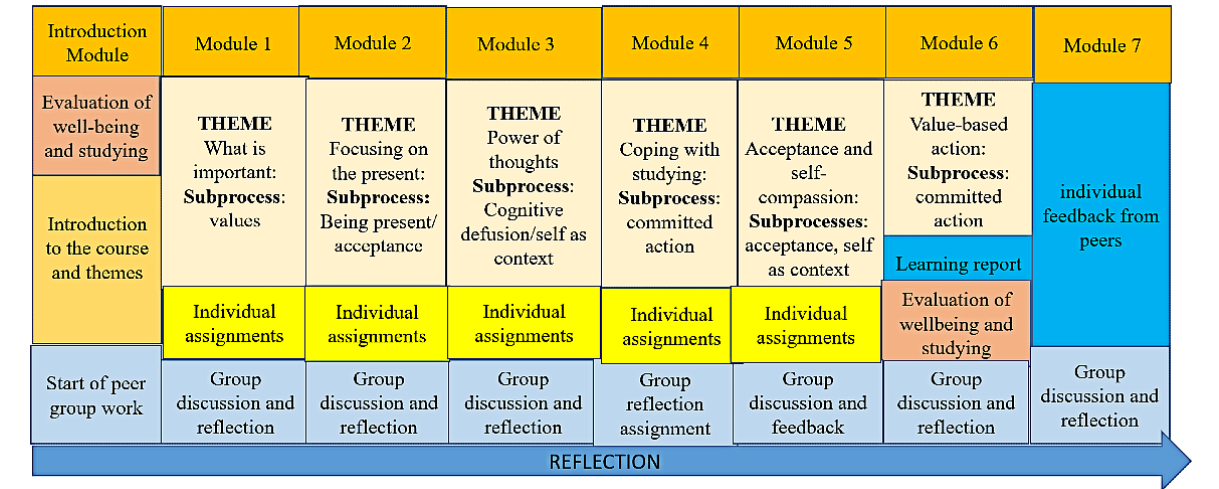
Figure 1. The design of the